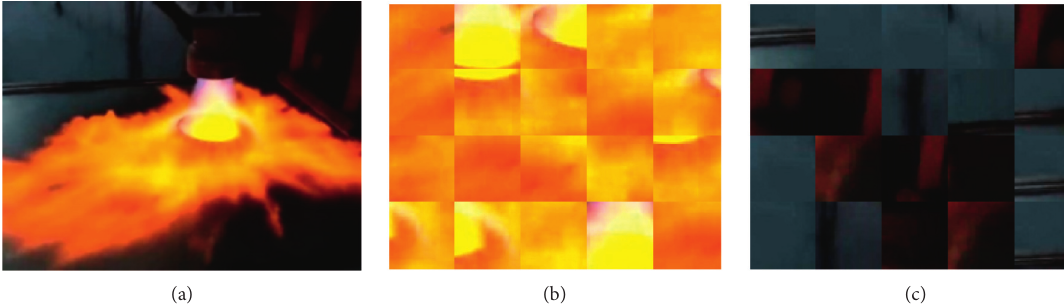
Figure 6: Extracting sample pixels from flame image I: (a) original flame image; (b) flame sample pixels; (c) nonflame sample